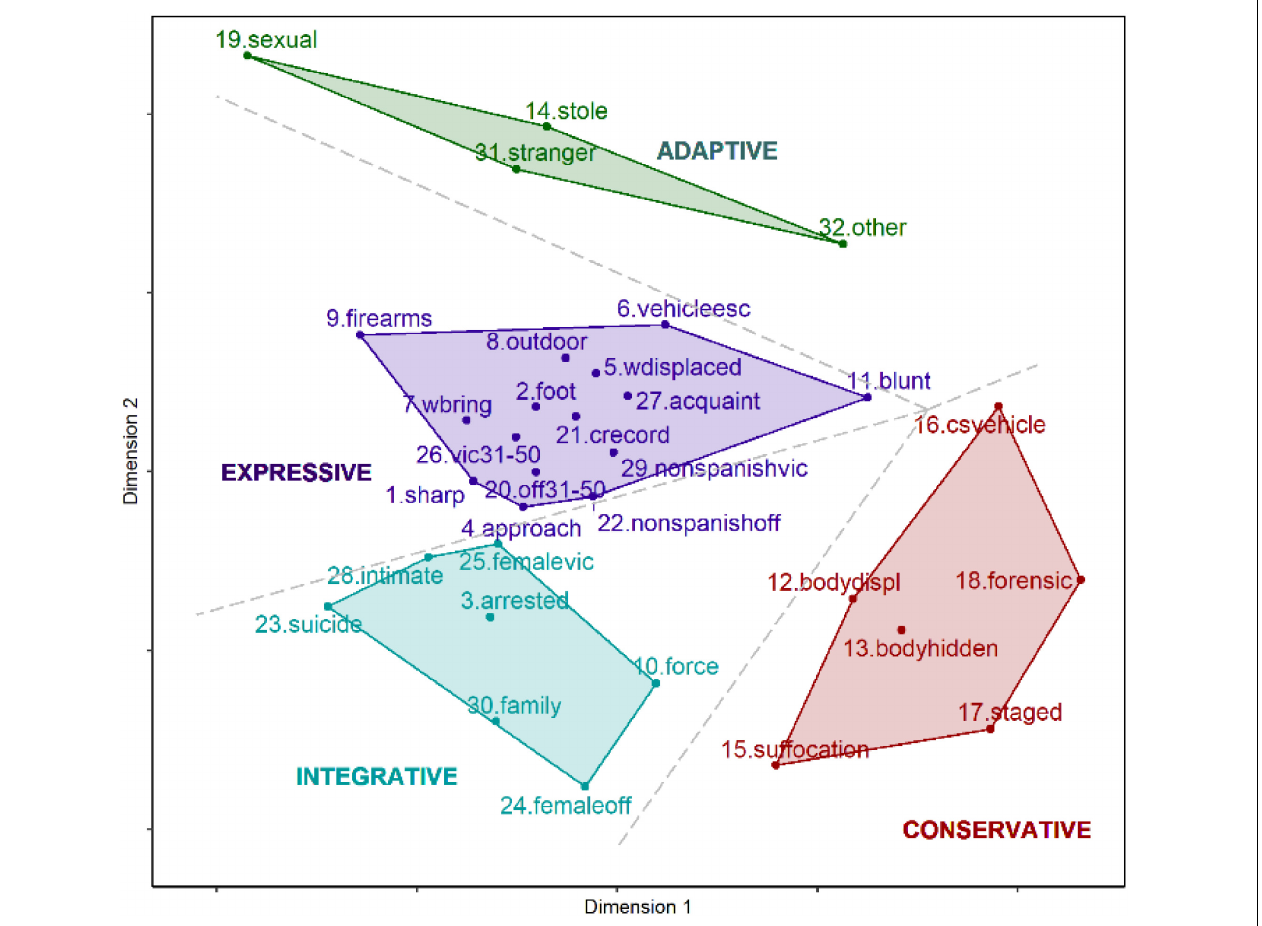
FIGURE 2 | Typology of simple homicides according to the Action System